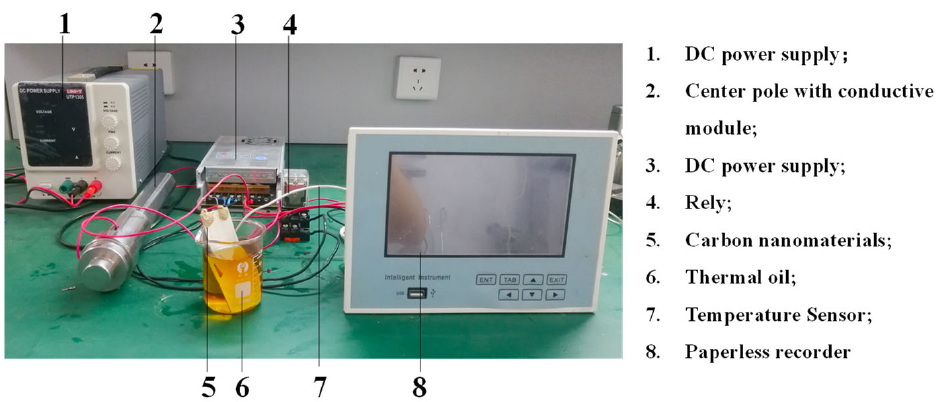
Figure 22. Conductive center pole resistance test.